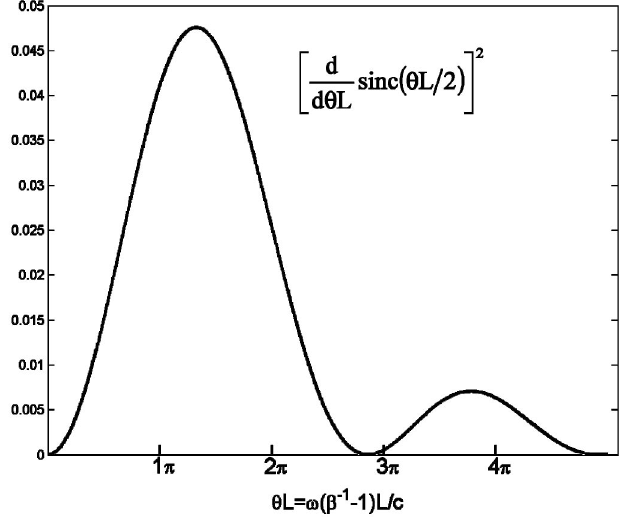
FIG. 5. The spectral energy line-shape function of the CSR radiation wave packet emitted by an electron passing through a magnetic bend